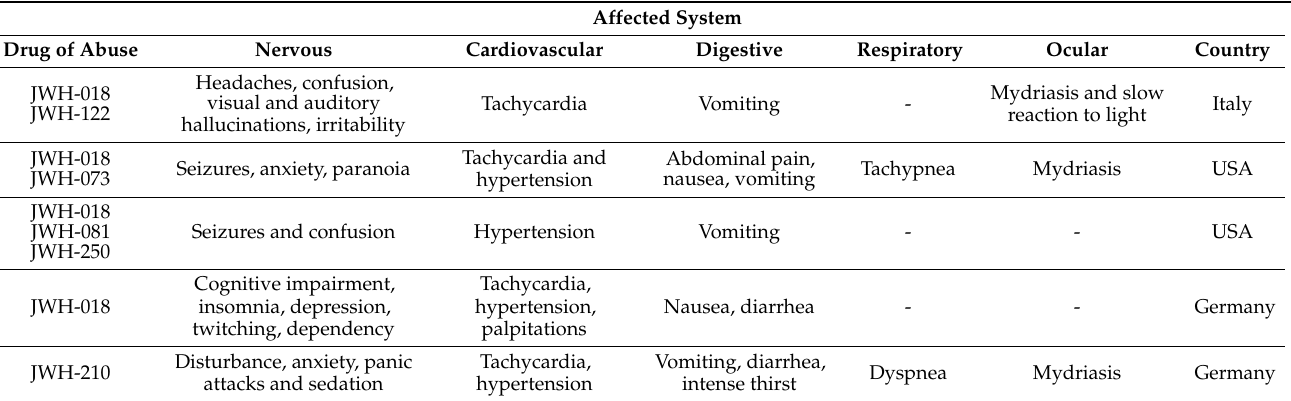
Table 1. Examples of clinical case, registered in Europe and USA, associated with the consumption of synthetic cannabinoids of the JWH series and respective symptomatology, in various systems. (Adapted from Tournebize et al.,